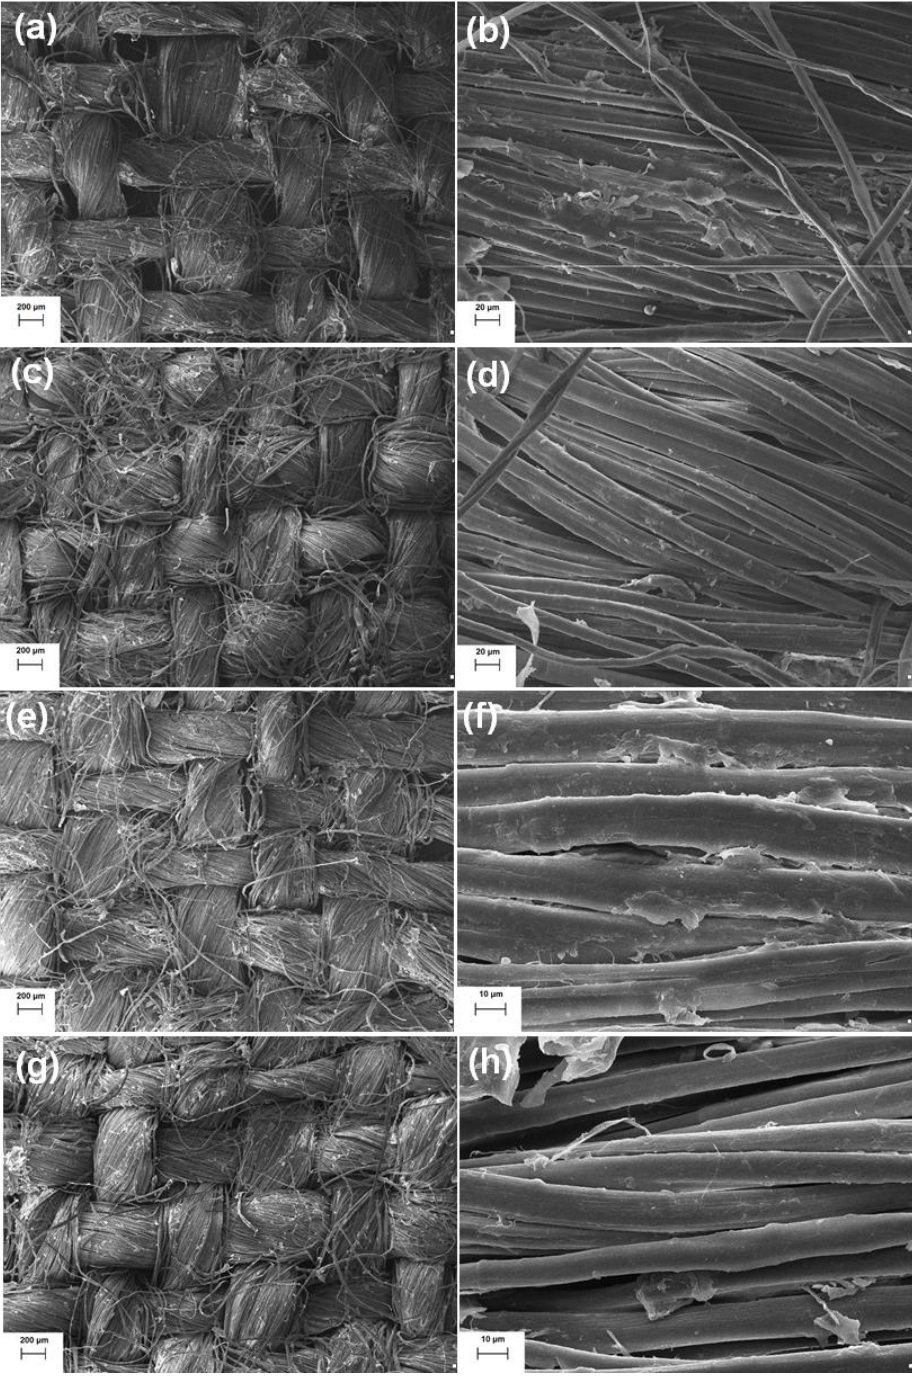
Figure 1. Scanning electron micrographs of: ( a , b ) raw linen woven fabric, ( c , d ) linen woven fabric after alkaline treatment, ( e , f ) linen woven fabric after enzymatic treatment with 2.5 U/g of laccase, ( g , h ) linen woven fabric after enzymatic treatment with 5.0 U/g of laccase.